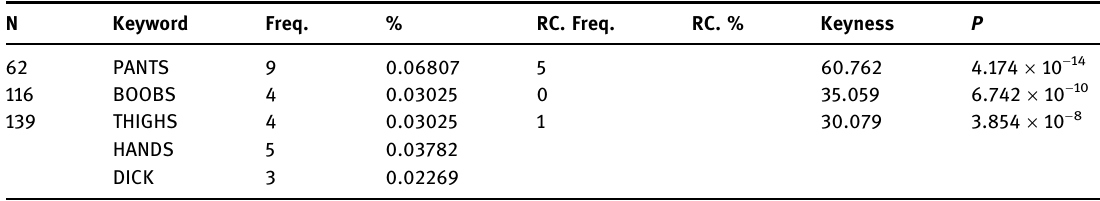
Table 43: Body parts and items of